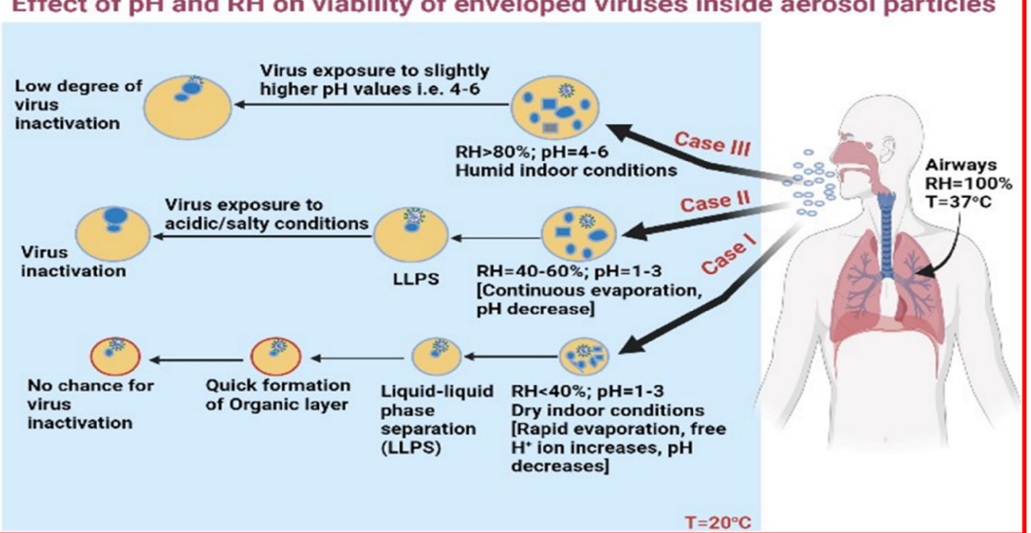
Figure 2. Impact of pH and RH on enveloped viruses’ viability inside viral aerosol particles (modified version [17,42] .